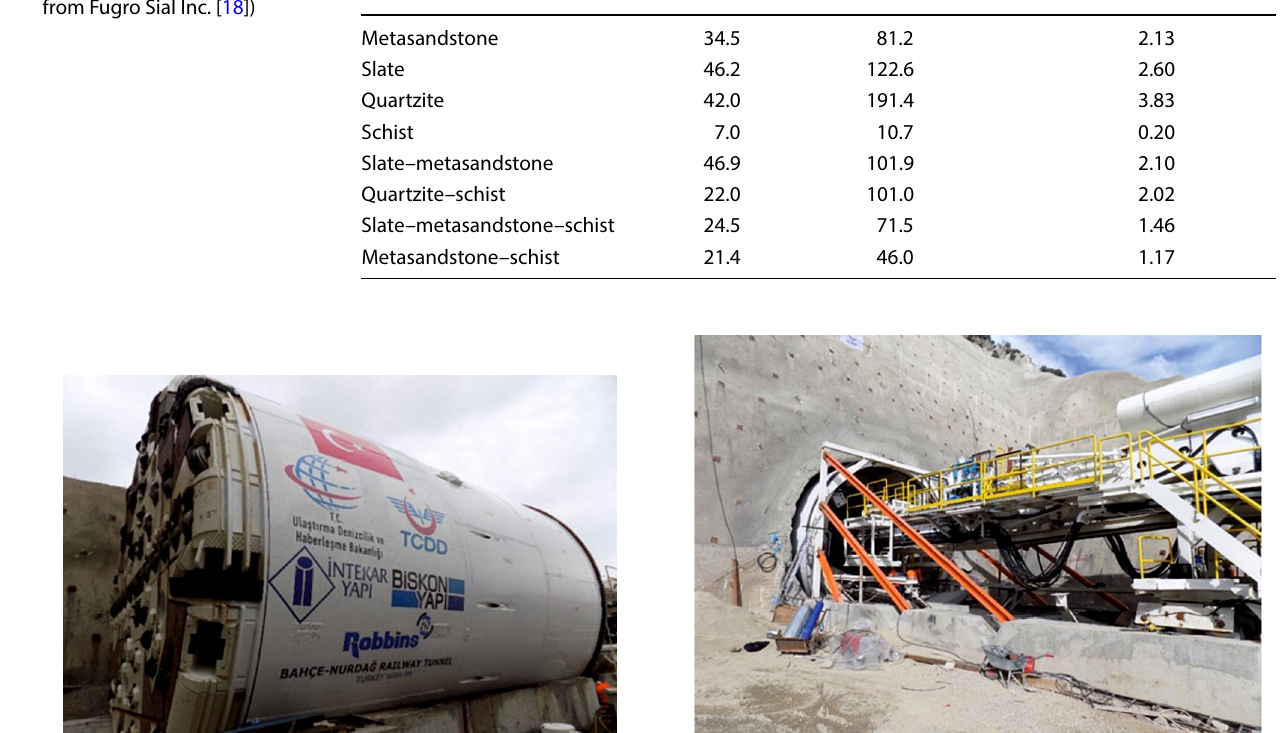
Table 1 Some average geotechnical parameters of the lithological units (compiled from Fugro Sial Inc. [18])